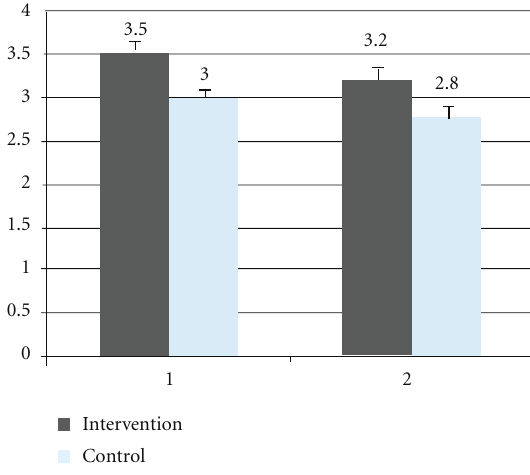
Figure 4: Mean modified Rankin scale score at one month and six months of the intervention and control group. 1; one month, 2; six months, mRs score range from 0 to 6, with higher scores indicating increasing severity.